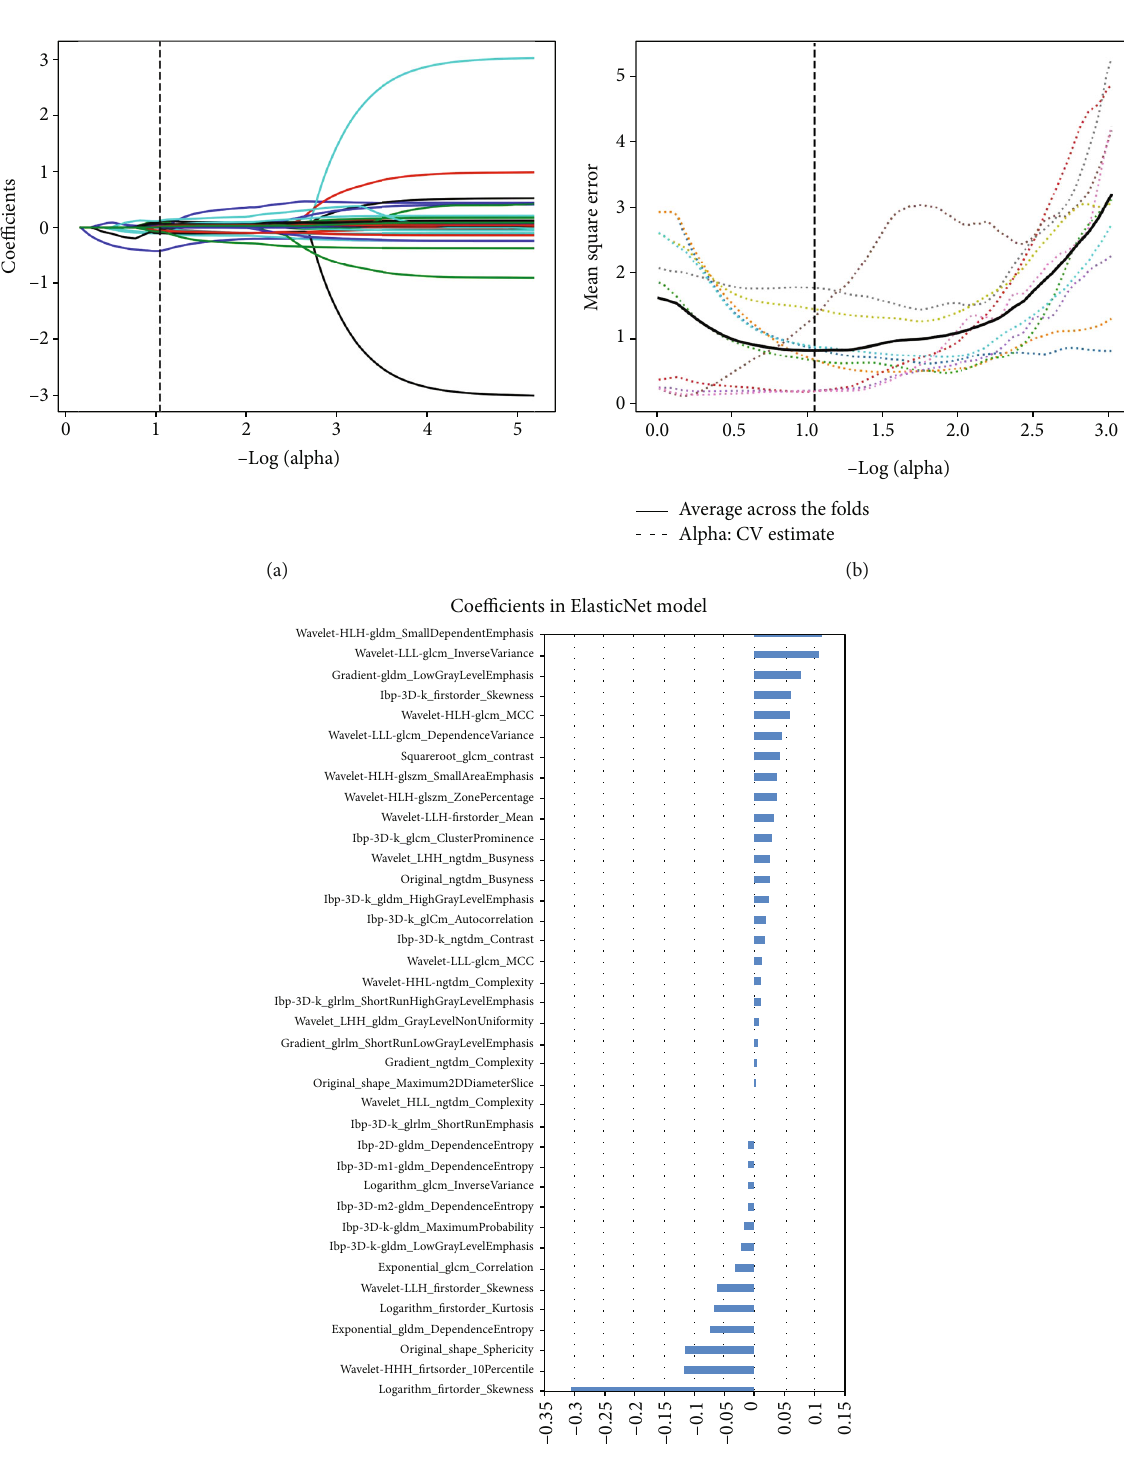
Figure 6: ElasticNet algorithm for feature selection. The fi rst (a) shows coe ffi cient pro fi les along the full path of possible values for radiomic features. The MSE path (b) indicates that the dotted vertical line was plotted at the value selected using 10-fold cross-validation in (a). The coe ffi cients in the ElasticNet model (c) resulted in 38 features based on selected optimal